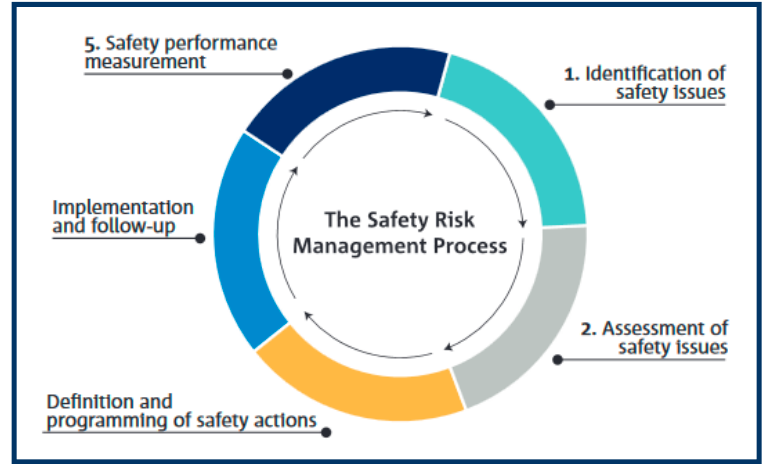
Figure 1. European Safety Risk Management Process (Annual Safety Review 2019 [1] (p. 21)).